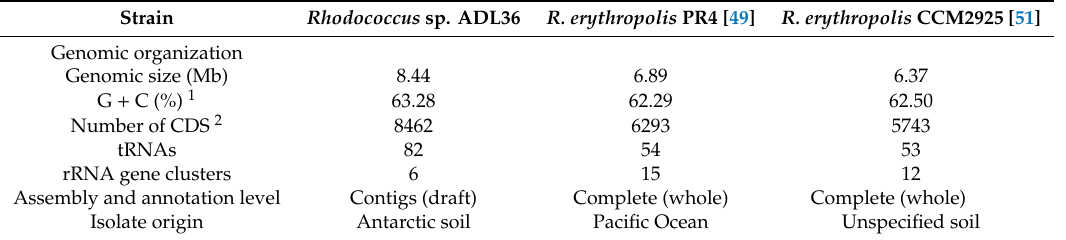
Table 1. General features of the genomes of Rhodococcus species that are closely annotated to Rhodococcus sp.